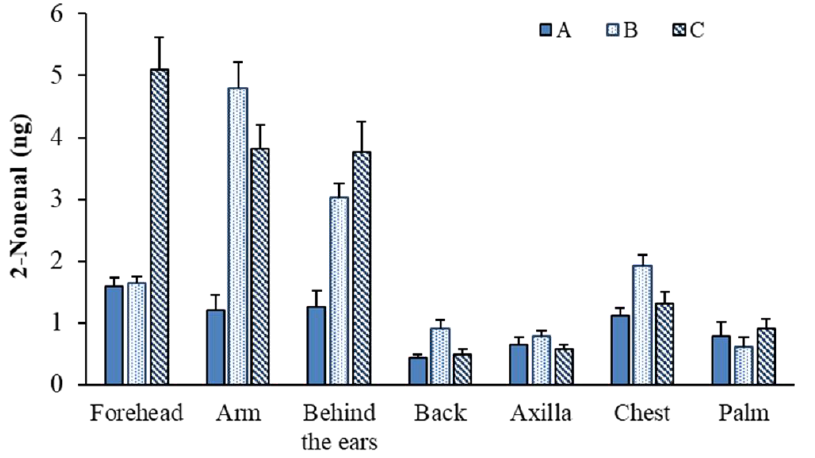
Figure 4. Comparison of 2-nonenal contents in body odor samples collected from several body parts (A: female in their 20s, B: male in their 20s, C: male in their 30s).